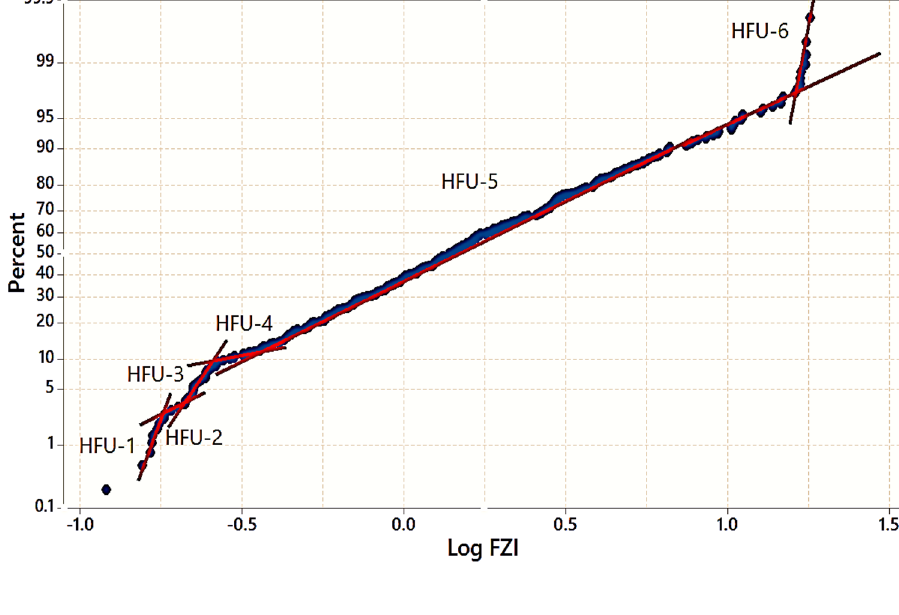
Fig. 13 Histogram of flow zone indicator (FZI) values represent- ing an approximately normal distribution and the presence of six